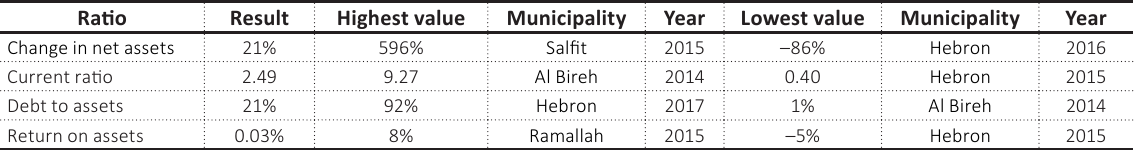
Table 9. The highest and lowest values of the